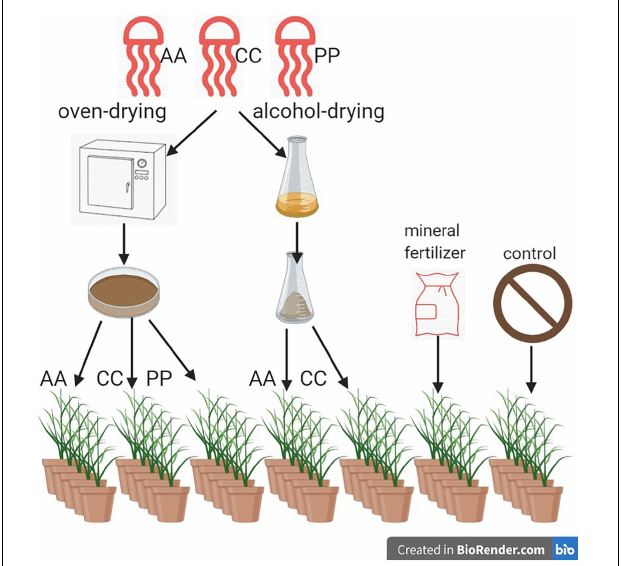
FIGURE 1 | Schematic representation of the experimental set-up and jellyfish treatments (AA, A. aurita ; CC, C. capillata ; PP, P. periphylla ).